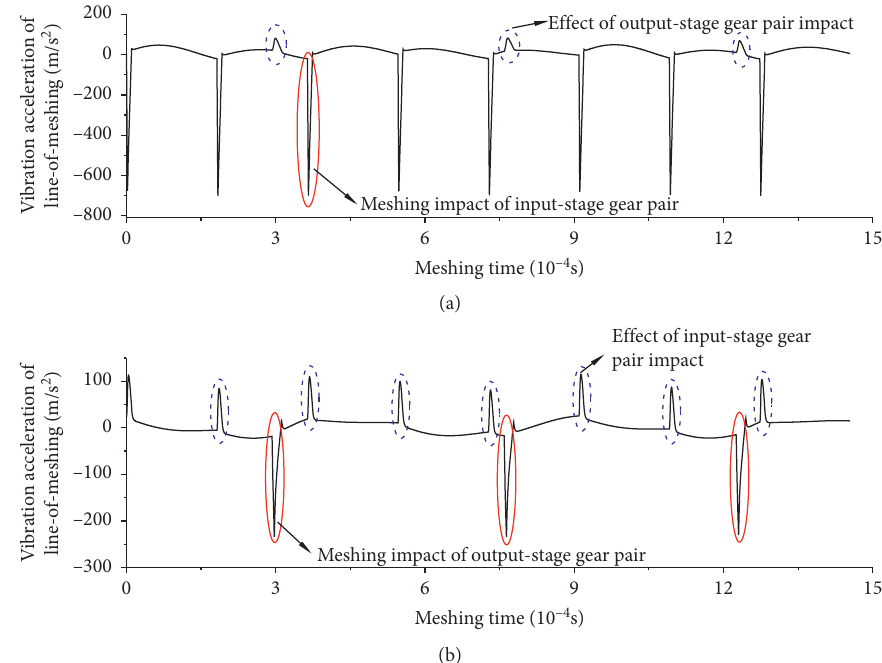
Figure 19: Time-domain diagram of two-stage helical gear transmission under excitation of meshing impact at 15,000rpm, (a) the input- stage gear pair, (b) the output-stage gear